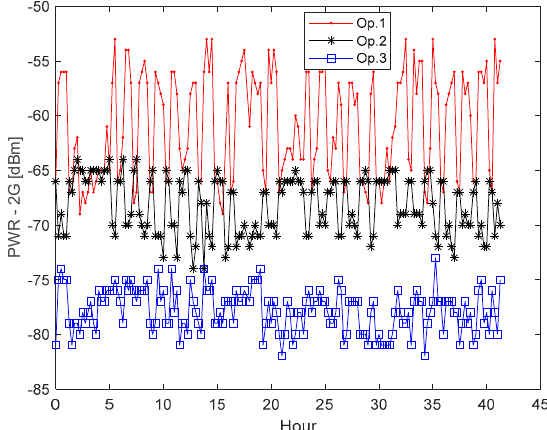
Figure 8. Measured received power (PWR) for 2G-GSM at probe A.